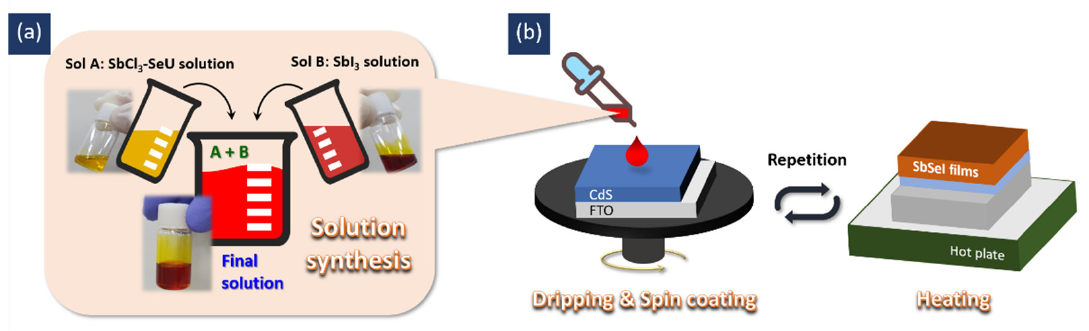
Figure 1. Schematic illustrations of ( a ) the synthesis of the one-step solution, and ( b ) the deposition process for SbSeI thin films.